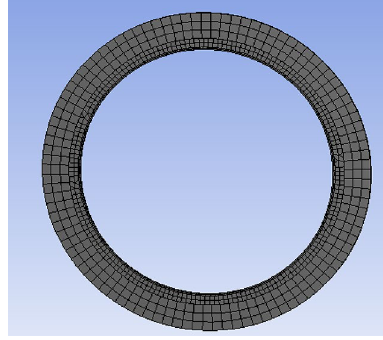
Fig. 4 Finite element model for plane stress